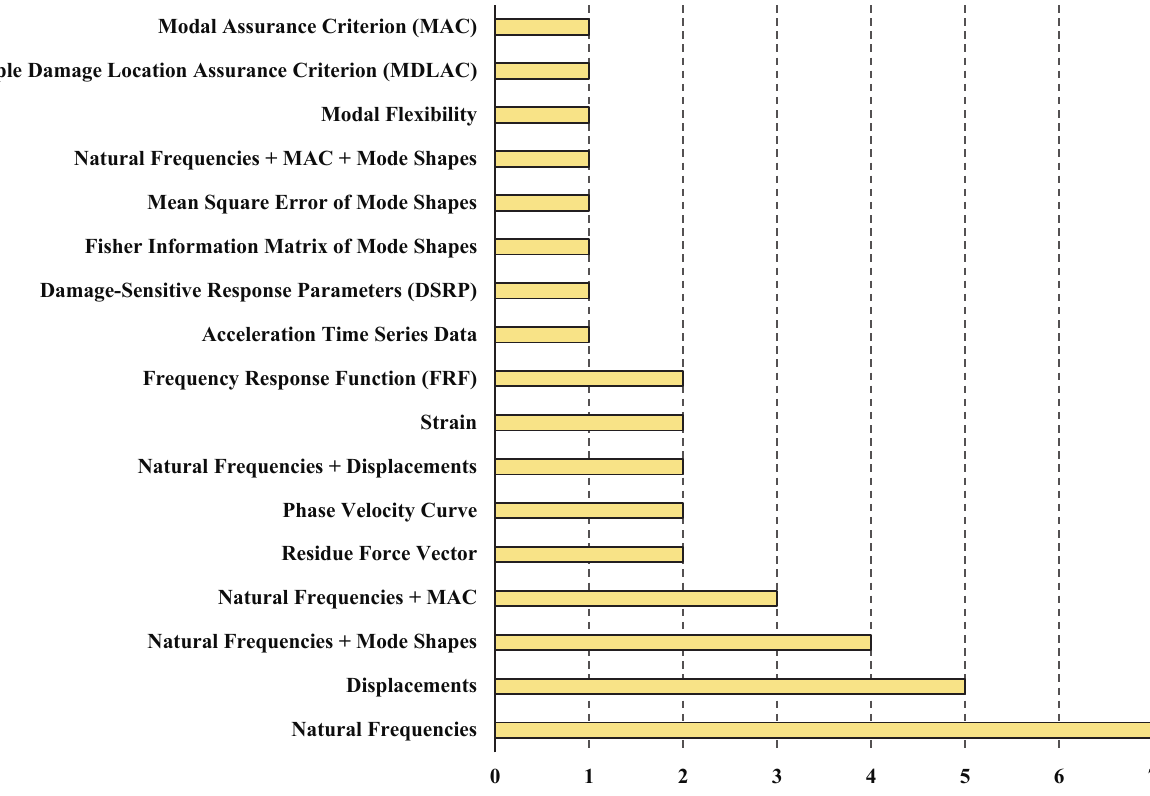
Figure 8: The classification of applied objective functions by the number of